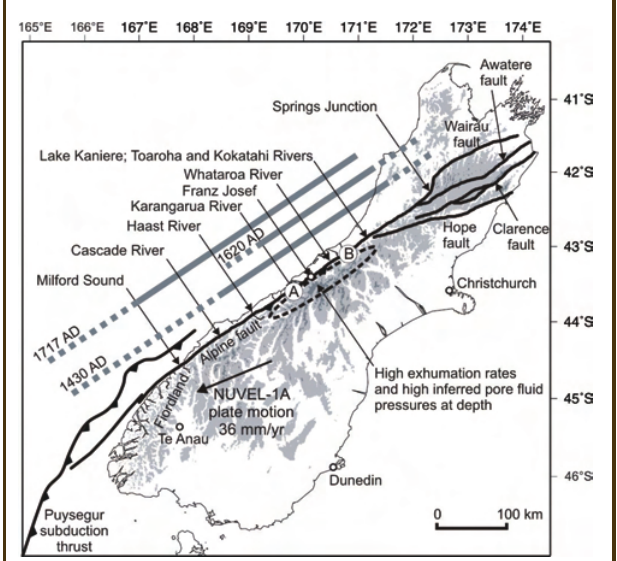
Figure 1. Map of the South Island of New Zealand showing principal features of the Australia–Pacific plate boundary and key locations referred to in the text. “A” and “B” mark the ends of the along-fault illustration in Fig. 4. The thick gray lines indicate the inferred extent of past Alpine Fault ruptures during historical times. Light gray shading demarcates topography higher than 800 m. Reproduced by permission of the American Geophysical Union after Sutherland et al., 2007. Copyright 2007 American Geophysical